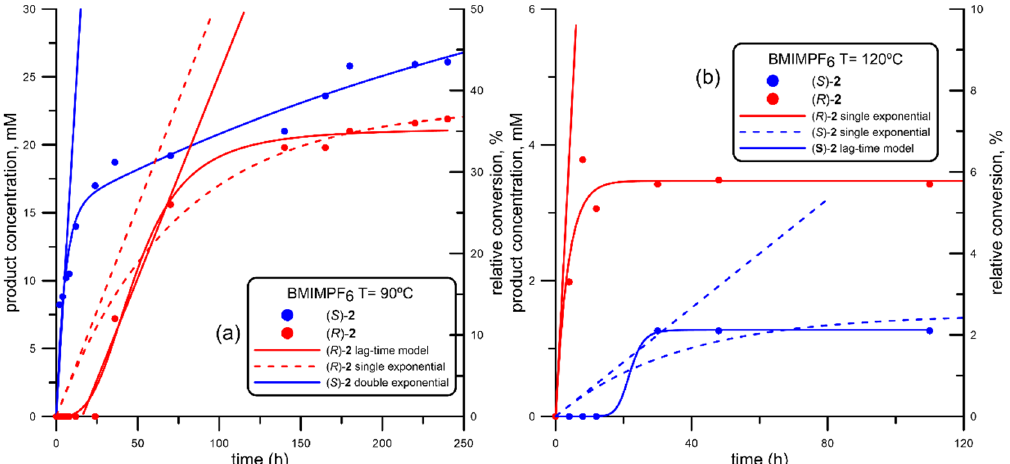
Figure 3. Progress curve of the BTL2-catalyzed production of both enantiomers of mandelic acid (( R )-acid, in red; ( S )-acid, in blue) via ethanolysis of racemic 2-(butyryloxy)-2-phenylacetic acid ( R , S )- 1 , using 1-butyl-3-methyl imidazolium hexafluorophosphate (BMIMPF 6 ) at different temperatures. ( a ) 90 °C; ( b ) 120 °C. Fitting parameters shown in Table 2, corresponding to entries #6 (BMIMPF 6 at 90 °C) and #7 (BMIMPF 6 at 120 °C).